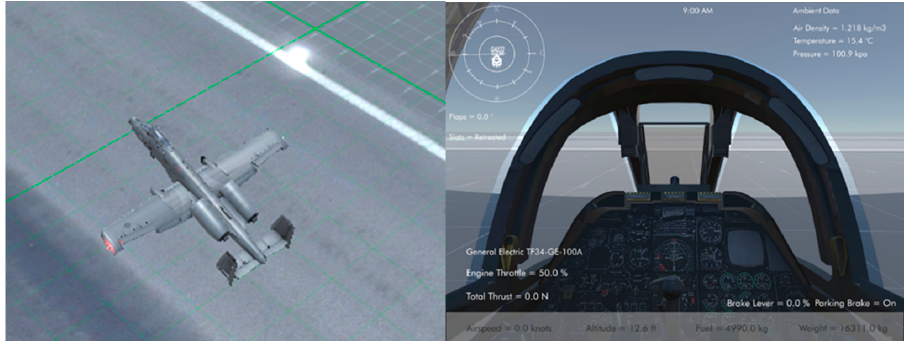
Figure 28. VR image of aircraft.